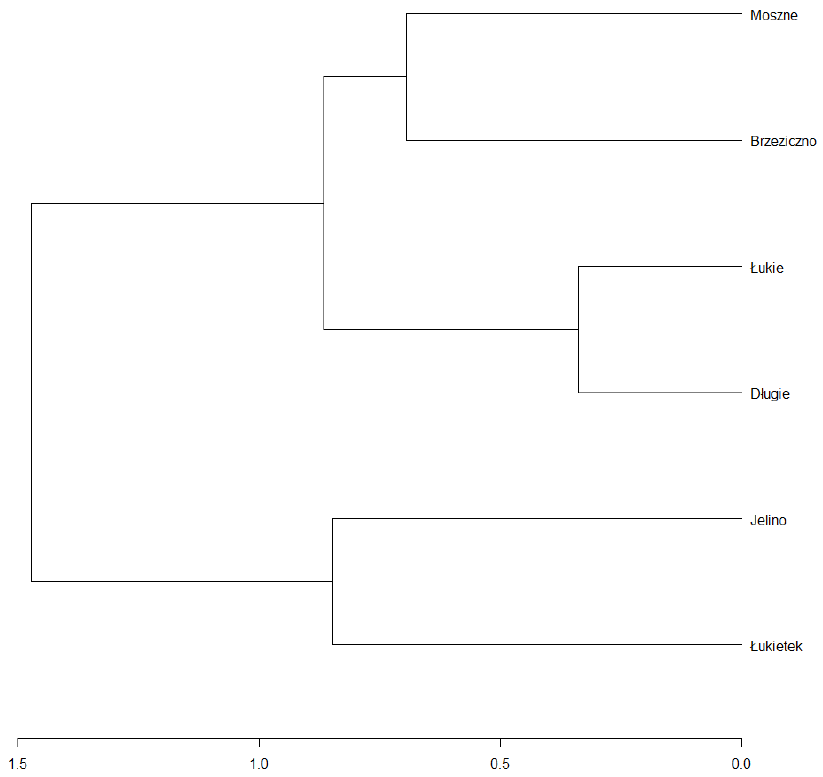
Figure 12. A dendrogram of the hierarchical cluster analysis based on binomial index and the average linkage method .